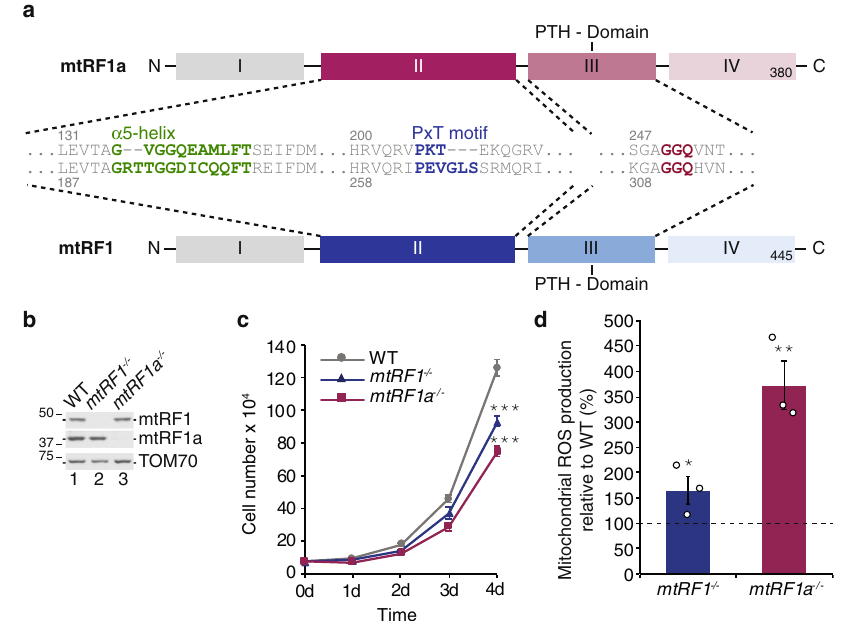
Fig. 1 | Consequences oflossofmitochondrial translationtermination factors. a Comparison of mtRF1a (top, red colors) and mtRF1 (bottom, blue colors). The domains I – IV of the mitochondrial release factors are shown in boxes. Corre- spondingsequencesofthedecodingmotifsindomainII( α 5helix:green;PxTmotif: blue) and the GGQ motif in the peptidyl tRNA hydrolase (PTH) domain III are indicated. b CRISPR/Cas9-mediatedknockoutofmtRF1andmtRF1a.Mitochondrial lysates (10 µ g for mtRF1a and 75 µ g for mtRF1) were separated by SDS-PAGE fol- lowed by western blotting and immunodetection using the indicated antibodies. c Ablation of mitochondrial release factors affects cellular growth. Cells (7.5×10 4 ) were seeded on day 0. Cell growth was monitored by cell counts for the indicated